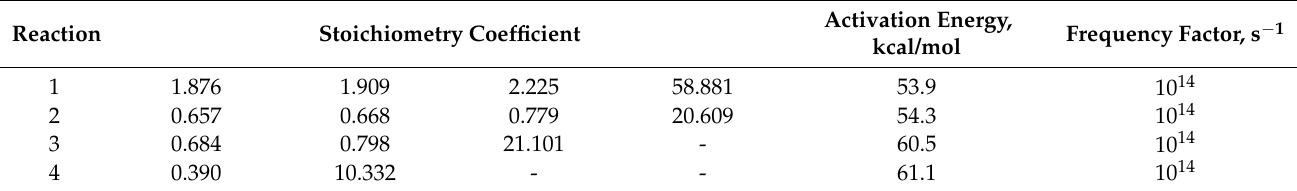
Table 4. Molecular weights of pseudo-components (in Daltons).